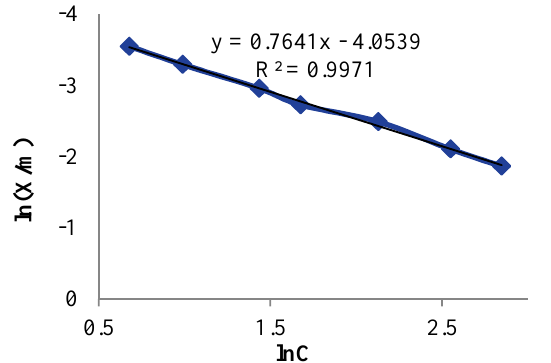
Figure 9. Freundlich model of humic acid (HA) absorption on activated carbon (AC) (pH = 6-7.5, T = 25 ºC, mixing time for AC = 16